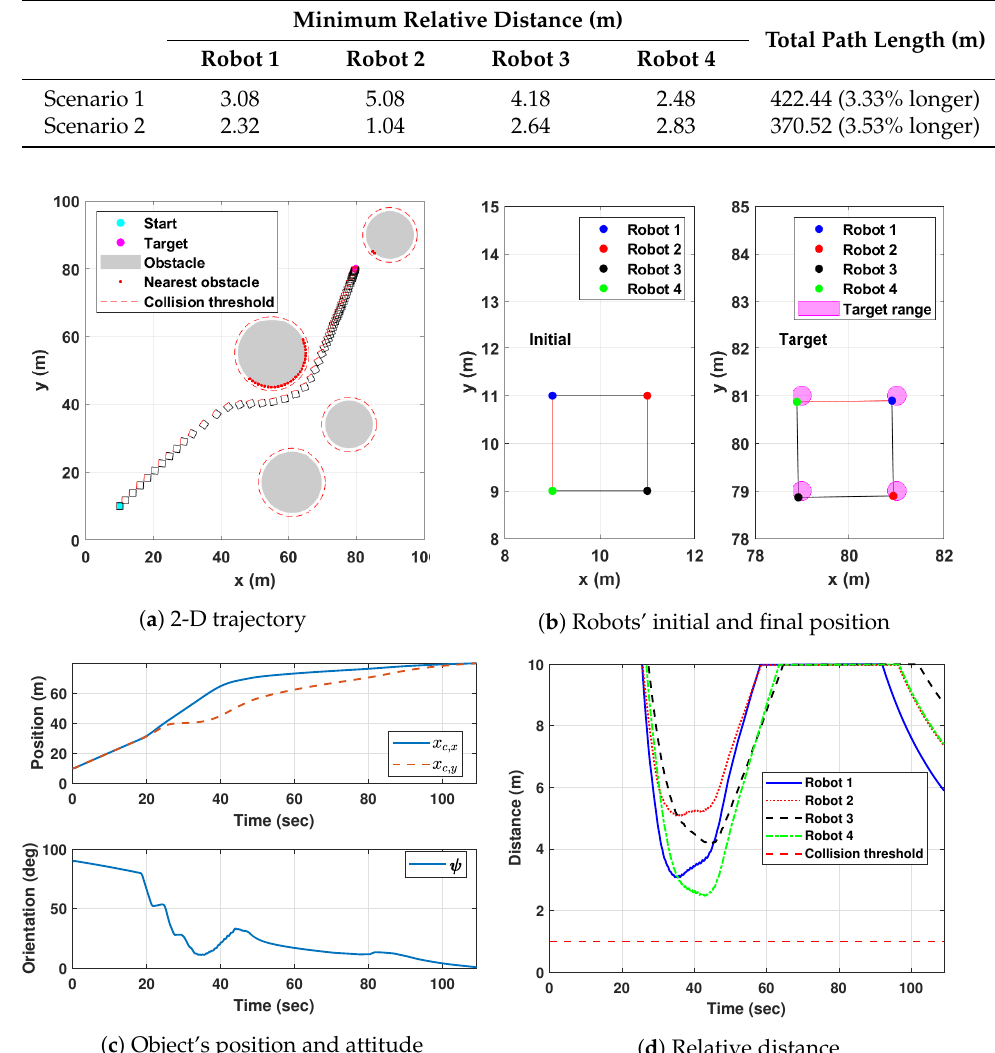
Table 5. Training results.